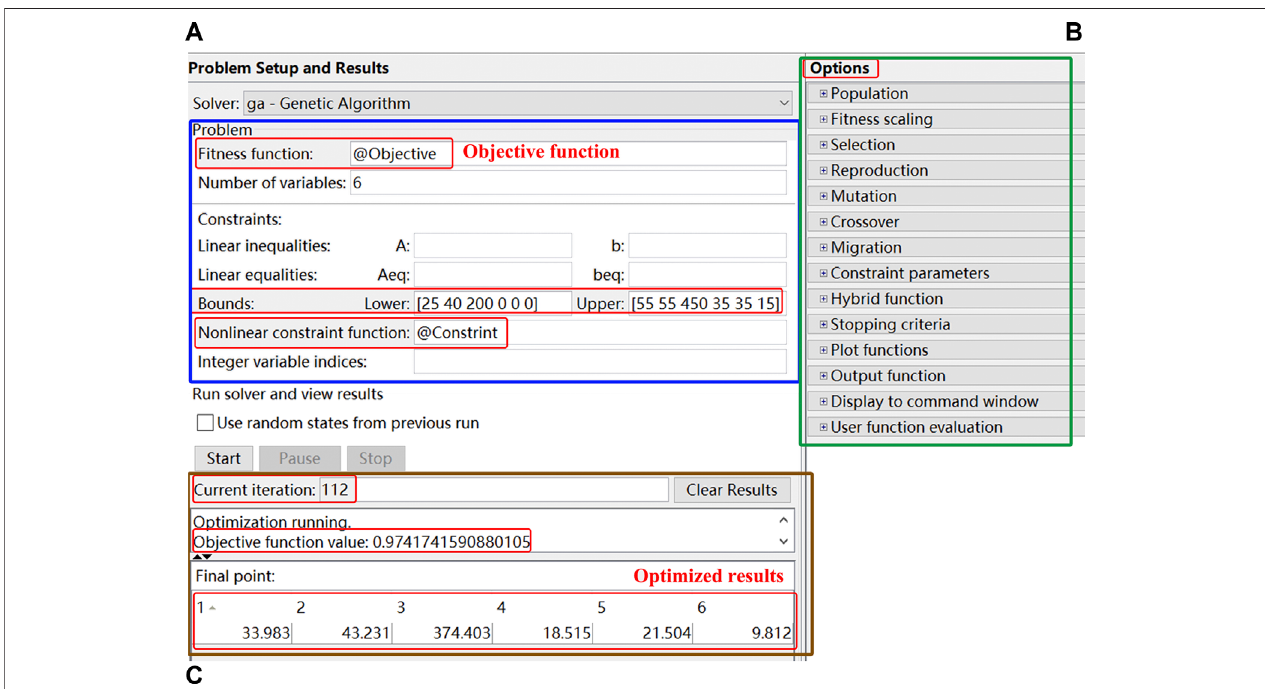
FIGURE 4 | Application of genetic algorithm toolbox.